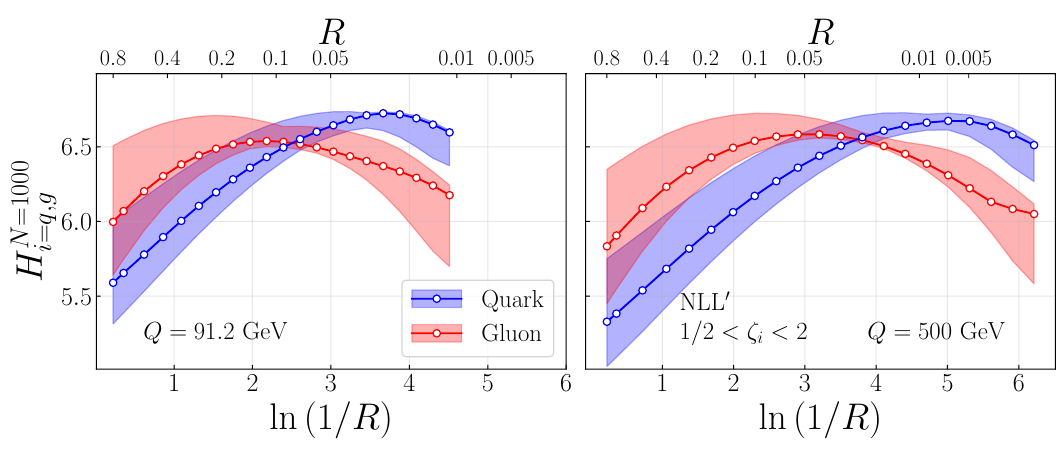
Figure 12 . Shannon entropy for quark and gluon jets and Q = 91 . 2 GeV and 500 GeV as a function of the jet radius R .